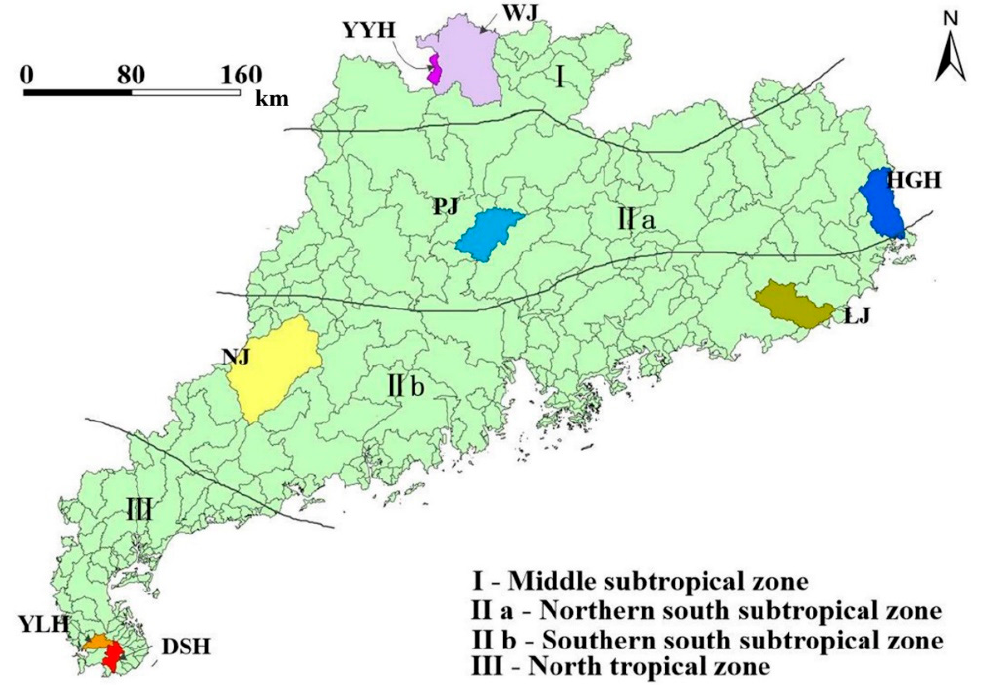
Figure 11. Basin-pairs of the four climatic zones in Guangdong.